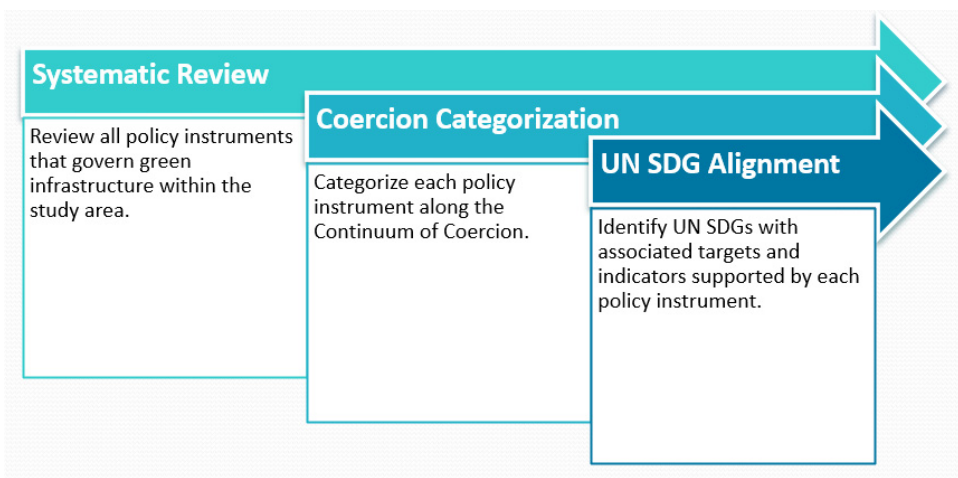
Figure 2. E-RIA methodological pathway